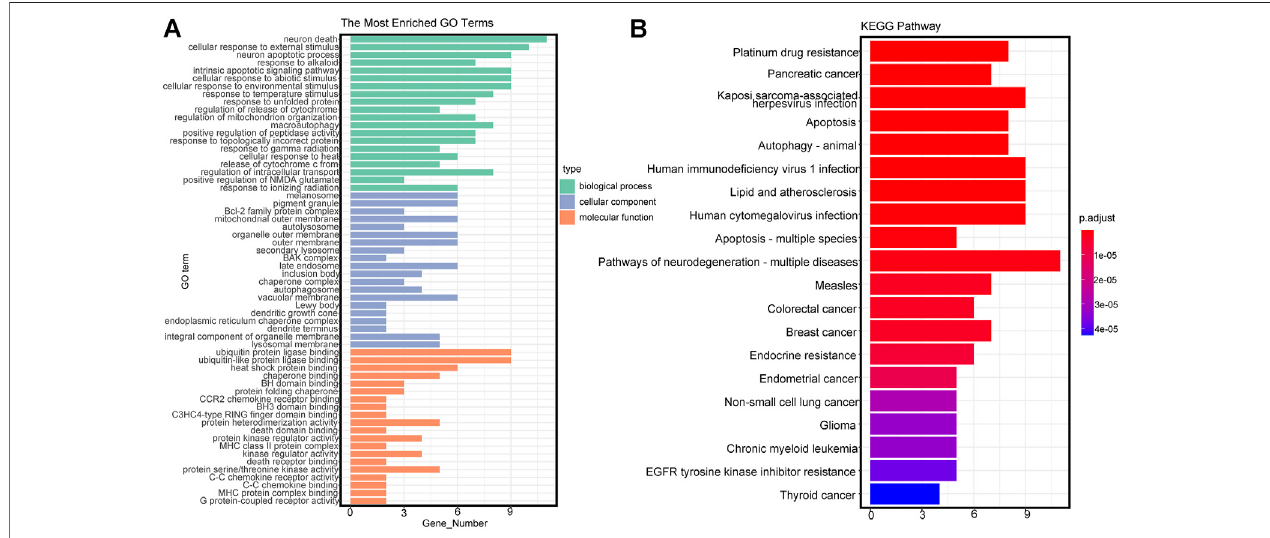
FIGURE 3 | Gene Ontology (GO) and Kyoto Encyclopedia of Genes and Genomes (KEGG) terms of differentially expressed autophagy-related genes. (A) GO analysis based on differentially expressed autophagy-related genes. BP, biological process; CC, cellular component; MF, molecular function. (B) KEGG analysis based on differentially expressed autophagy-related